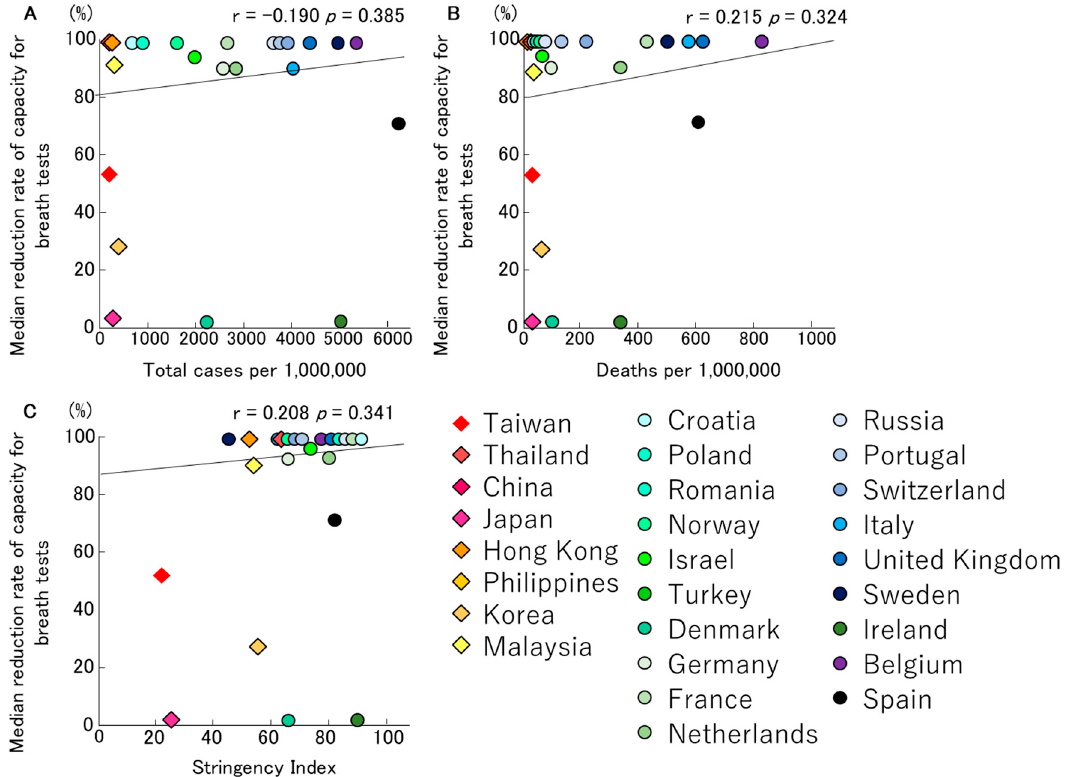
Figure 5. The relationships between median reduction rates of capacity for breath tests, total infection rate ( A )/mortality rate ( B ) for COVID-19 and Stringency Index ( C ) in Asian and European countries, are described. No significant trends were observed in the relationships between the median reduction rates of breath tests, total infection rate/mortality rate of COVID-19 and Stringency Index.